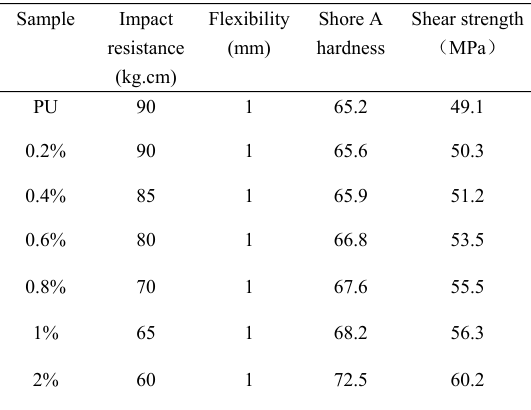
Figure 2: FTIR spectra of silicon oxide nanofibers.